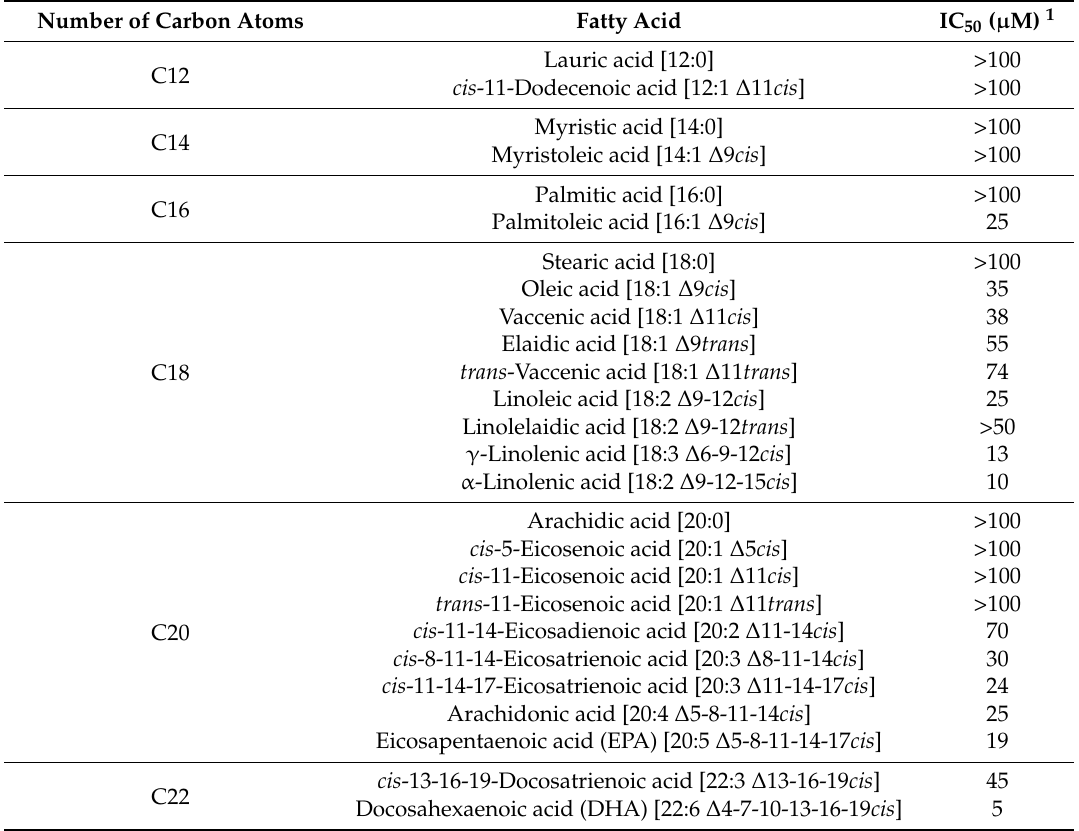
Table 2. IC 50 values of various fatty